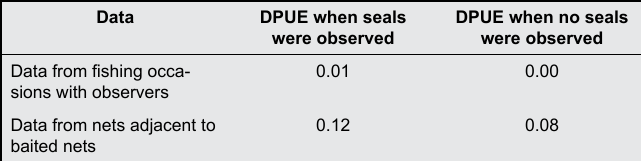
Table 4. Mean DPUE (number of damaged fish m net -1 day -1 ) in 2 data sets, relating to whether seals had been observed or not. DPUE when seals DPUE when no seals were observed were